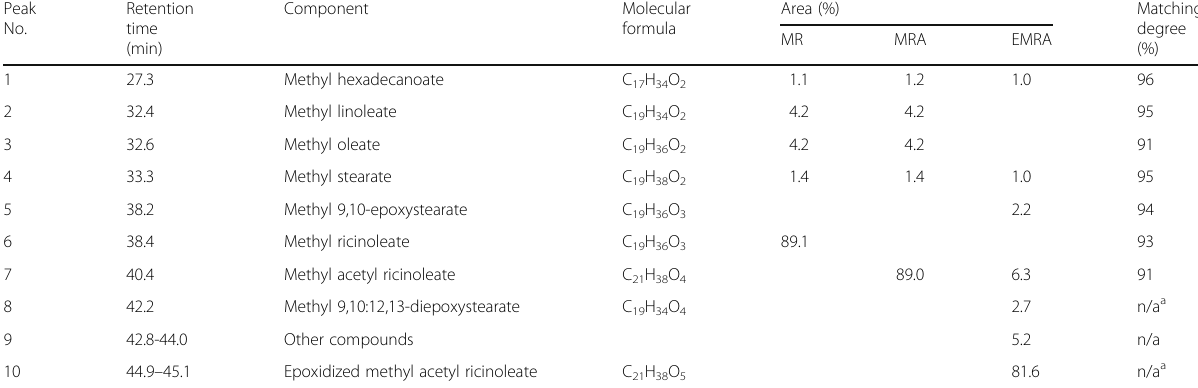
Table 2 Composition of MR, MRA, and EMRA identified by comparing the experimental mass spectra of the components in Fig. 3 against NIST08 mass spectral library Peak